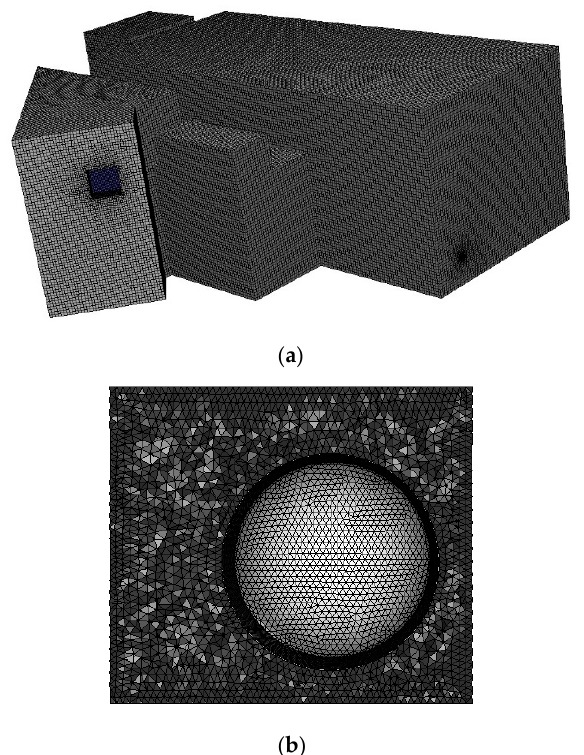
Figure 2. Meshing of computing domain. ( a ) Overall computational domain. ( b ) Local mesh of scattering room.